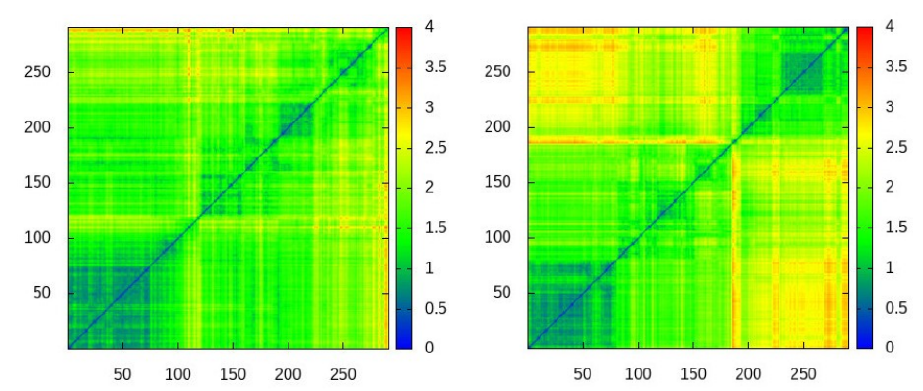
Figure 5. 2D-RMSD plot, showing in a color scale the RMSD between all the structures sampled along the MD trajectory, for each of the two ubiquitin molecules in the simulation with TIP4P/2005 water at 5 mM concentration. The scale in both axes is in tens of ns. The same color scale, in Å, is used in both